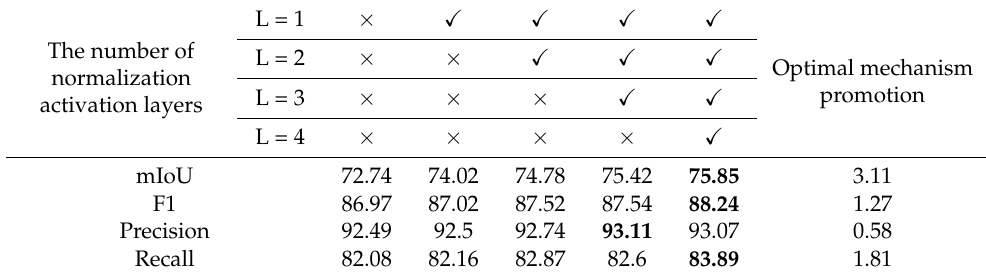
Table 4. Ablation experiment of the normalization activation layer.